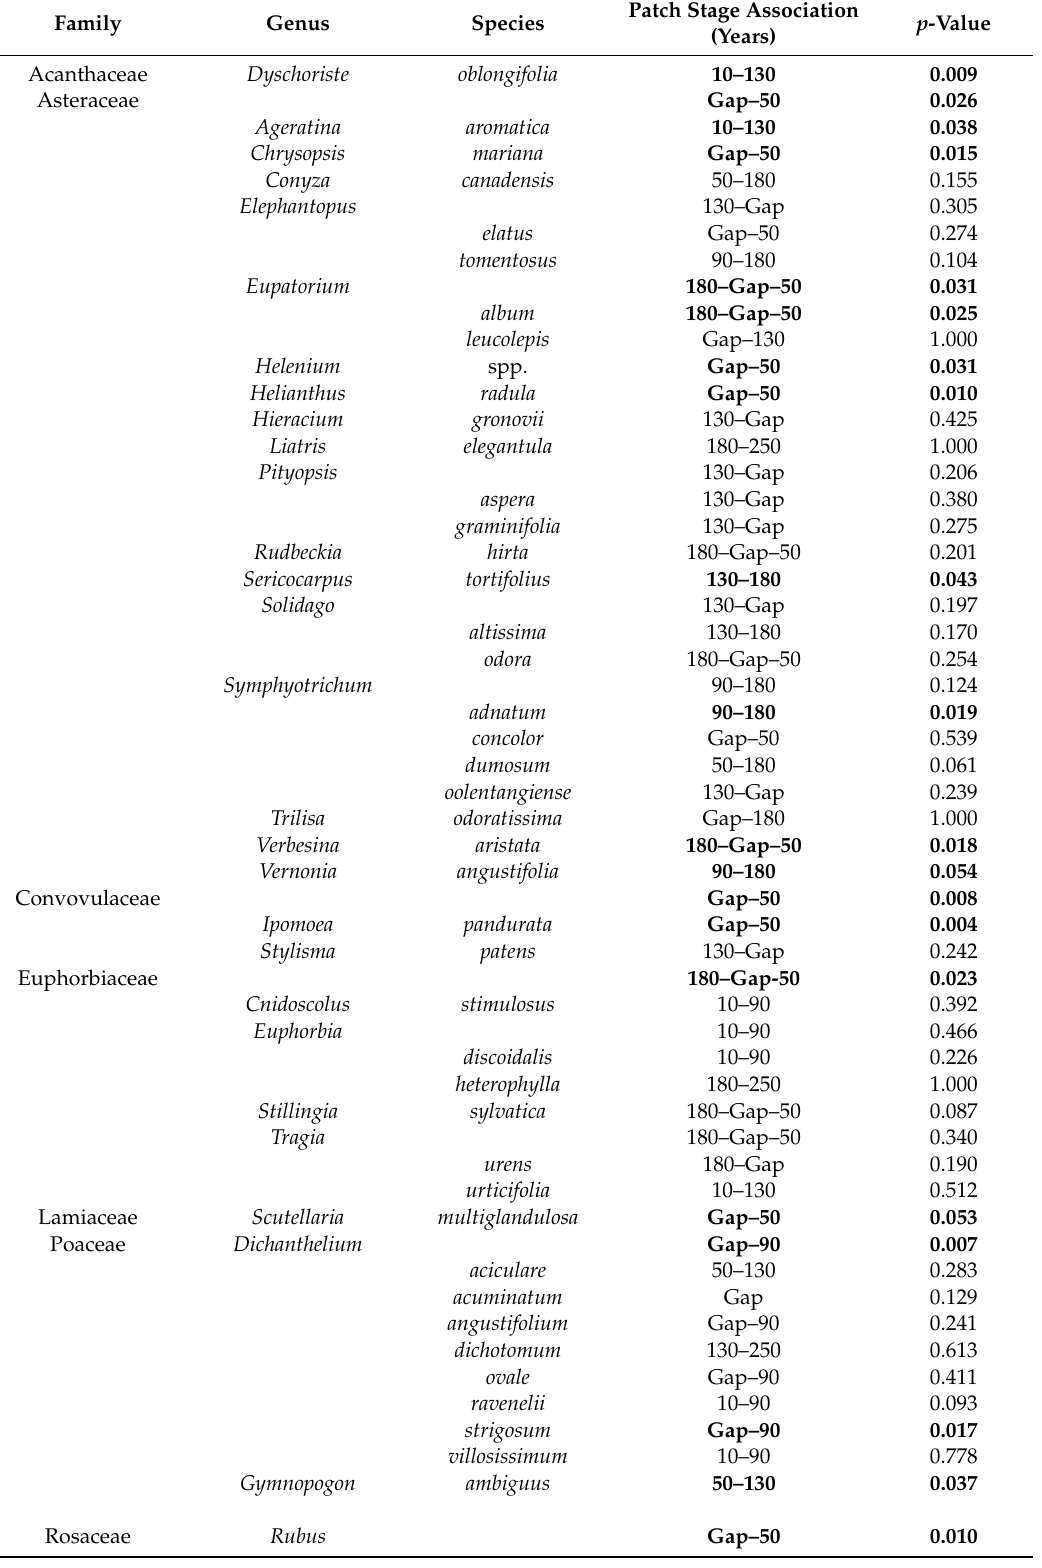
Table 2. Indicator species analysis results including the patch stage or stage group with which species, genera, and families were most strongly associated. Taxonomic groups included are those with at least one significant result. Bold p -values indicate significant